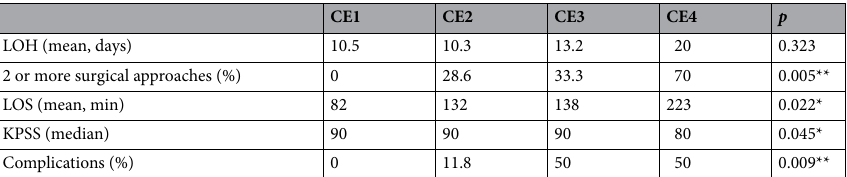
CE1 CE2 CE3 CE4 p LOH (mean, days) 10.5 10.3 13.2 20 0.323 0 28.6 33.3 70 0.005** 82 132 138 223 0.022* 90 90 90 80 0.045* 0 11.8 50 50 Table 3. LOH (length of hospital stay), percentage of patients undergoing 2 or more operations for tumor resection, LOO (length of operation), and postoperative Karnofsky Performance Status Scale (KPSS). CE1: Intraosseous lesion, CE2: Destruction of the osseous clival cortical bone, CE3: Brainstem reached without compression or infiltration, CE4: Compression/infiltration of the brainstem, * p < 0.05, ** p < 0.01.